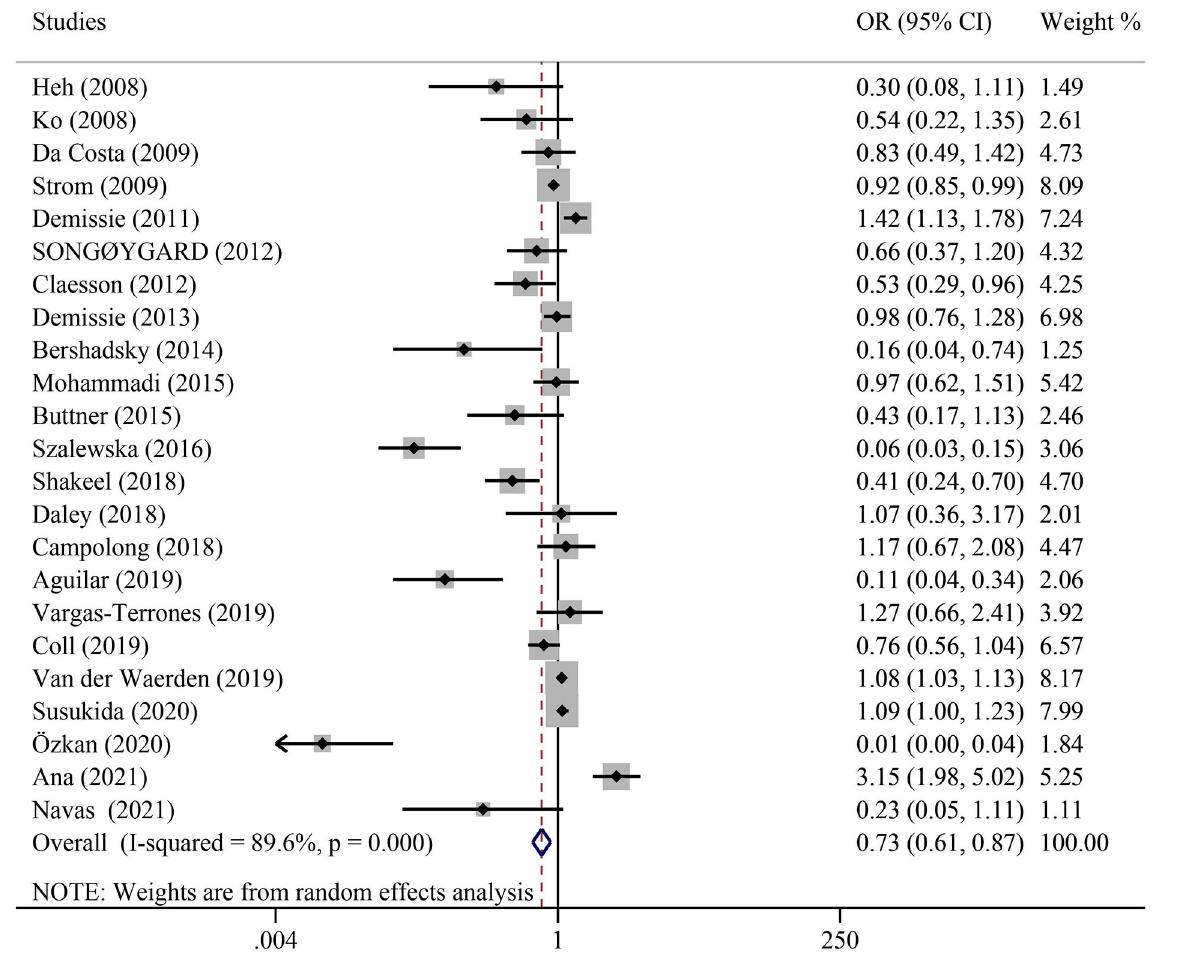
FIGURE2 Overall analysis of the association between physical activity and postpartum depression with odds ratio (OR) and 95% confidence interval (CI).